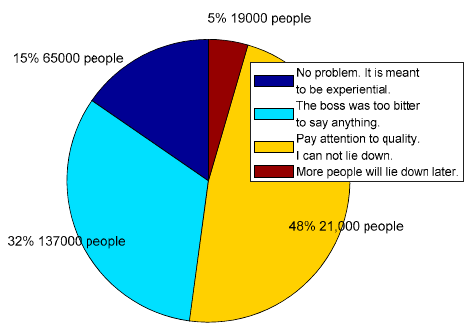
Figure 15. Opinion distributions of “Sleep”, “Cool” events.